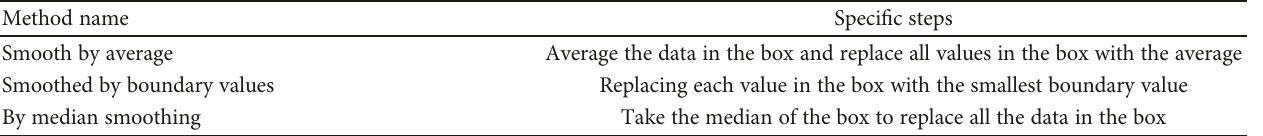
Figure 2: Data sources. Table 1: Summary of data smoothing